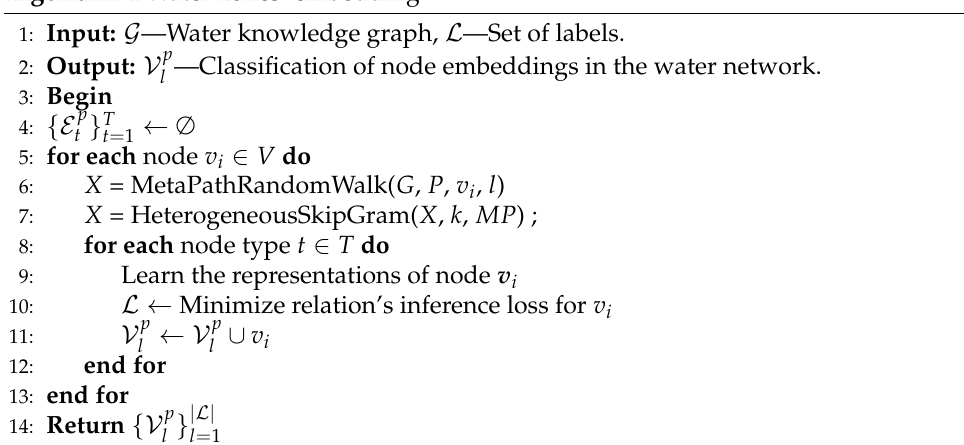
Algorithm 1 Water zones’